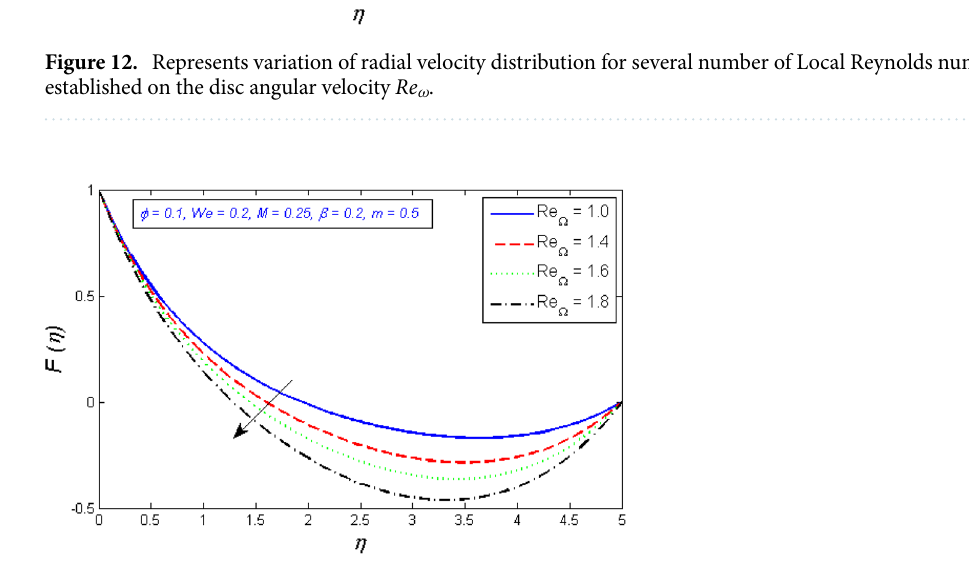
Figure 13. Represents variation of radial velocity distribution for several number of Local Reynolds number established on the cone angular velocity Re (cid:31)